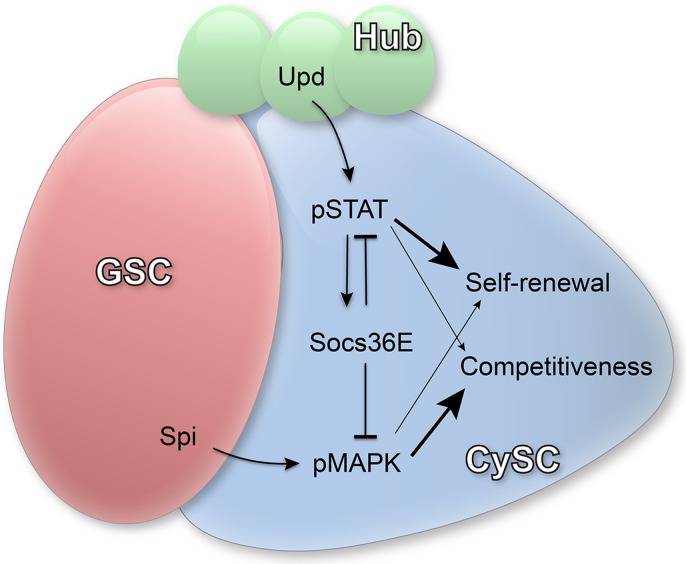
Model for the role of Socs36E in CySCs.Upd is produced by hub cells (green) and activates Stat92E (pSTAT) in CySCs (blue). JAK/STAT signaling upregulates the expression of Socs36E, which negatively regulates both JAK/STAT and MAPK signaling. pSTAT in CySCs primarily controls self-renewal (bigger arrow) but may also impact competition (smaller arrow). Spi is produced by GSCs/germ cells (red) and results in the activation of MAPK (pMAPK), which primarily regulates competitive behavior (bigger arrow) of CySCs but may also impact self-renewal (smaller arrow). In the absence of Socs36E, both JAK/STAT and MAPK pathways have elevated activity, resulting in increased self-renewal and increased competition.